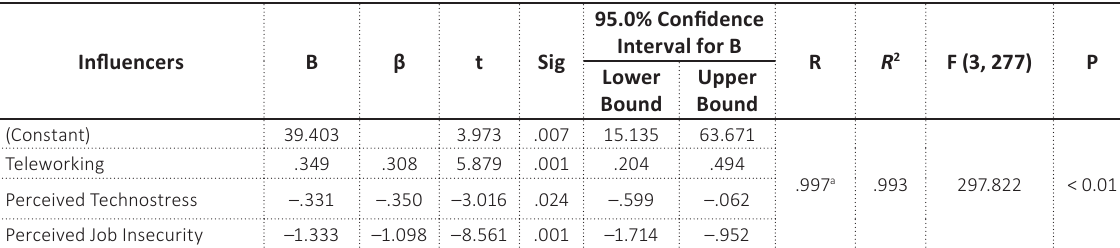
Table 2. Measurements of OP predictors